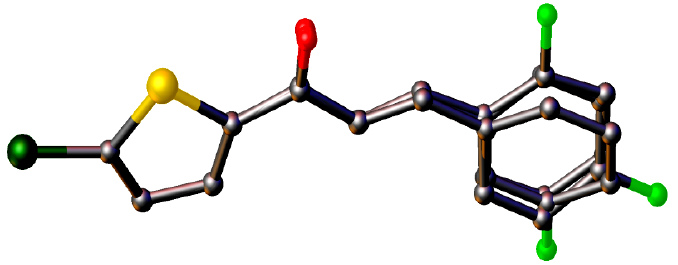
Figure 3. Overlay of all non-H atoms in compounds 3a , 3b and 3c , calculated using the chlorothiophene moiety.